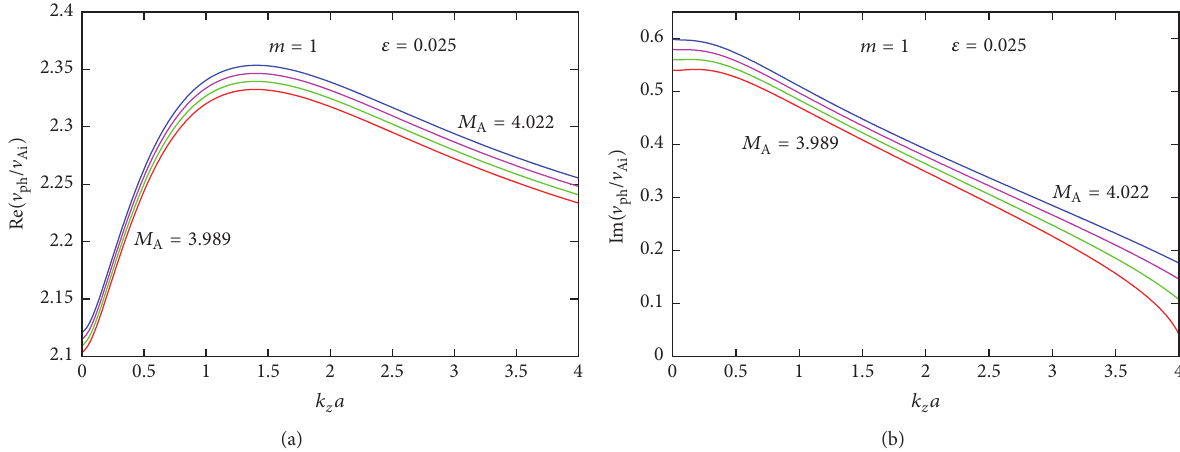
Figure 6: (a) Dispersion curves of unstable kink ( 𝑚 = 1 ) MHD mode propagating in a moving twisted flux tube of incompressible plasma (modeling jet #11) at 𝜂 = 0.896 and 𝜀 = 0.025 and for 𝑀 A = 3.989 , 4.0 (green curve), 4.011 (purple curve), and 4.022 . (b) The normalized growth rates for the same values of 𝑀 A .